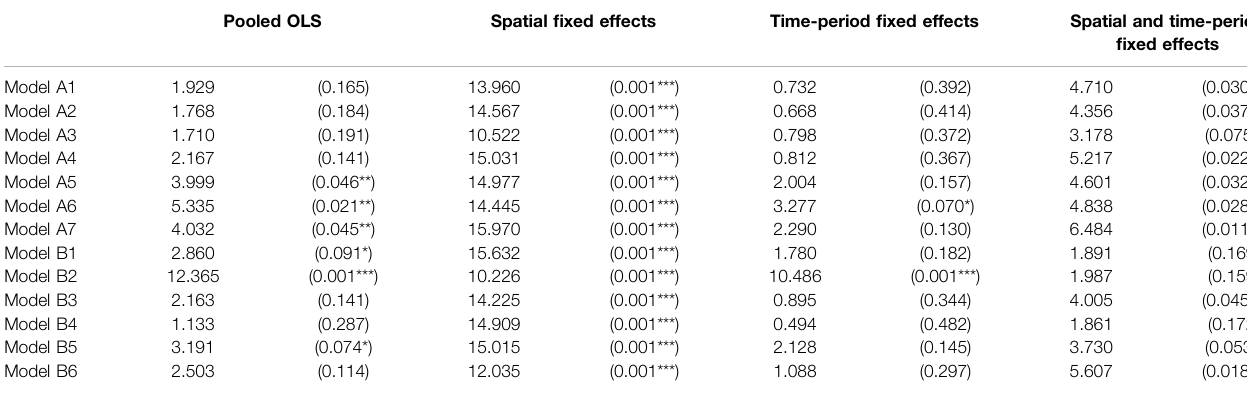
TABLE 5 | Spatial error in the spatial and time-period fi xed-effect model. Pooled OLS